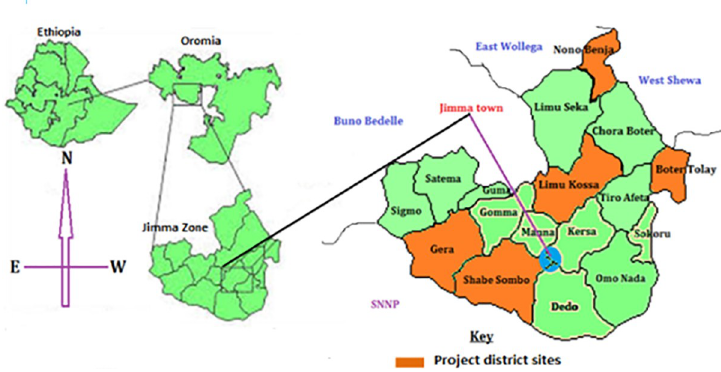
Fig 1. Map of the Jimma zone and target districts in Oromia, Ethiopia (Adapted from Google, Wikipedia).